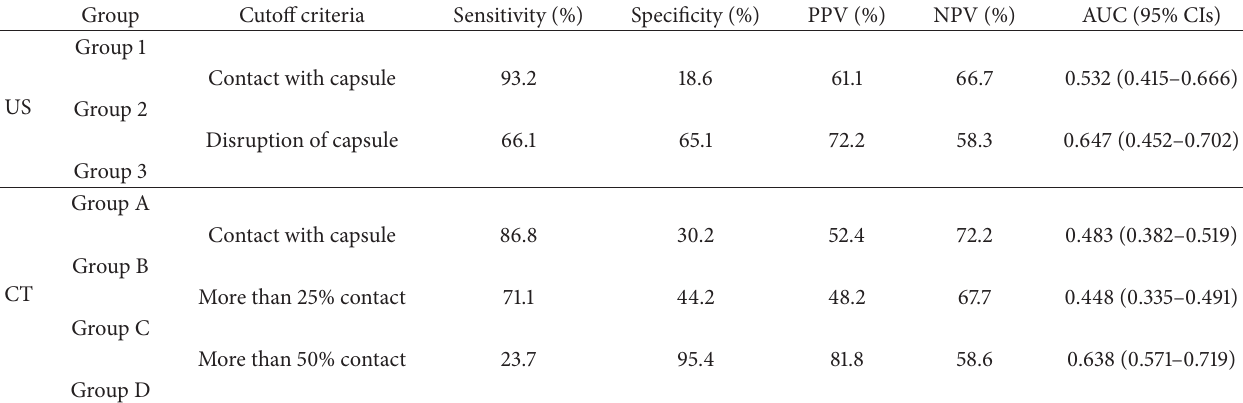
Table 2: Diagnostic accuracy of preoperative US and CT to predict the extrathyroidal extension.